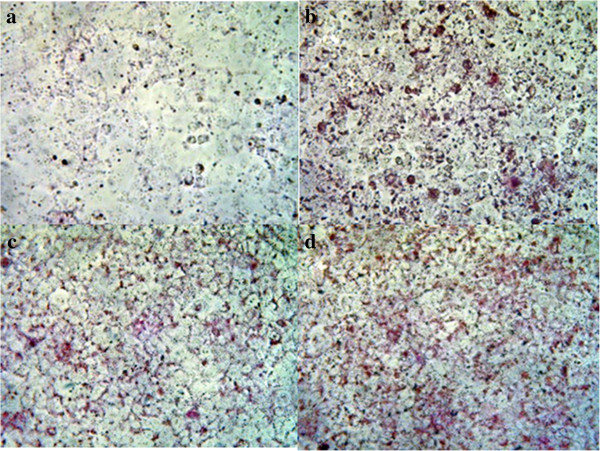
Lipid accumulation in Huh7 cells. Lipid accumulation was detected in Huh7 cells by staining with Oil Red O. The images were captured by microscopy at a magnification of 20×. a. Untreated cells. b. Cells after 9 hours of treatment with 500 μM palmitate. c. Cells after 9 hours of treatment with 400 μM linoleate. d. Cells after 9 hours of treatment with both 500 μM palmitate and 400 μM linoleate.